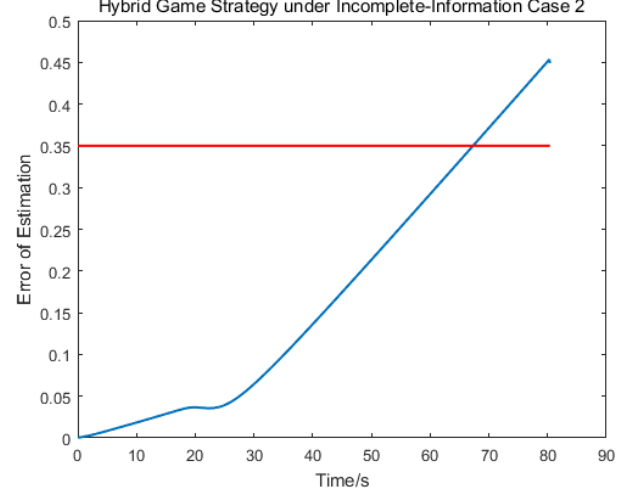
Figure 15. Error estimation of (cid:101) X .